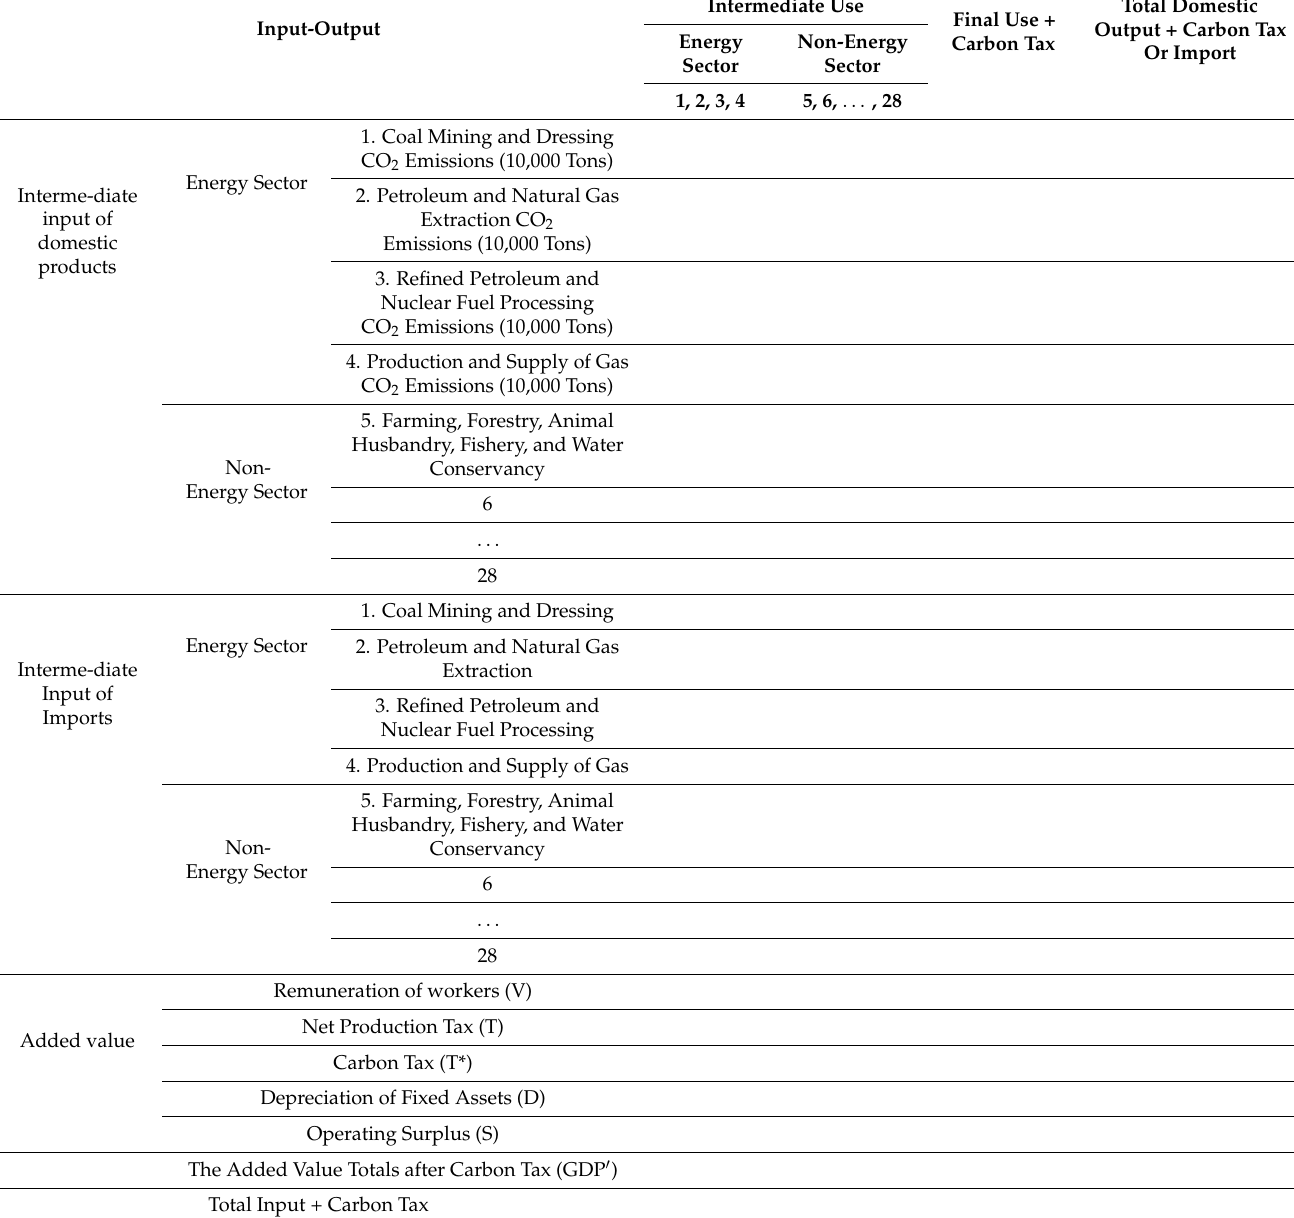
Table 1. 2018 Non-competitive input–output tables of China for carbon emissions after carbon tax; (calculated at producer’s price) Unit: 10,000